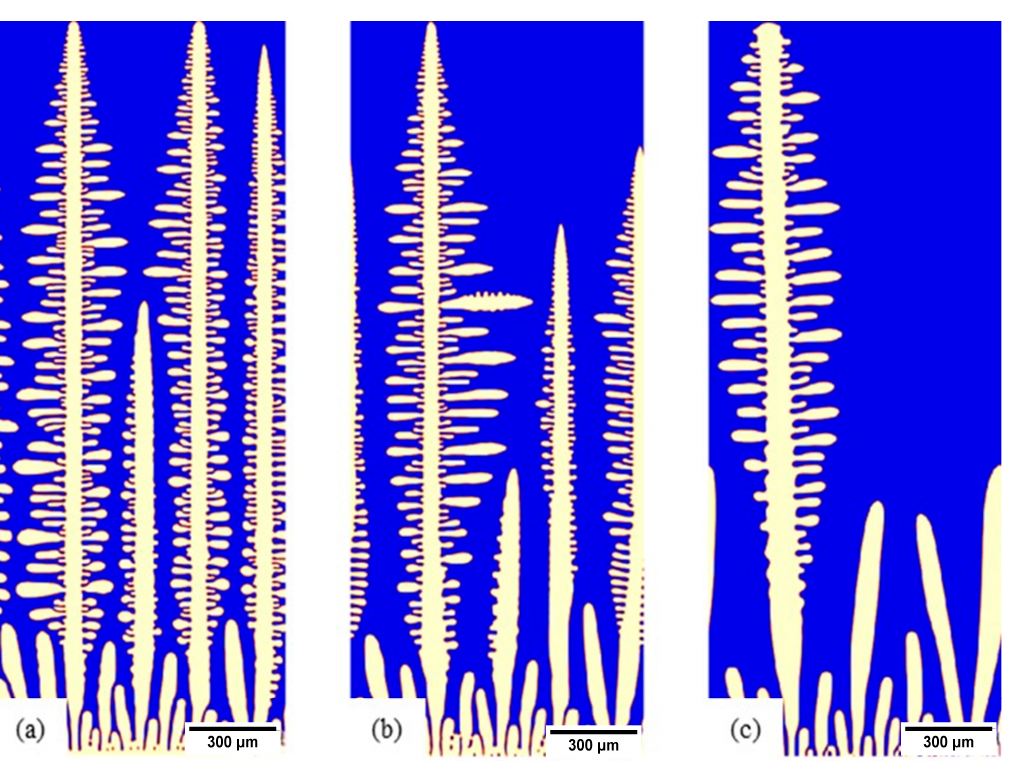
Figure 11. S32101, 100 °C superheated microstructure when growing dendrites reached the top of the simulation domain: ( a ) chill surface, ( b ) 10 mm in the slab, and ( c ) 50 mm in the slab.